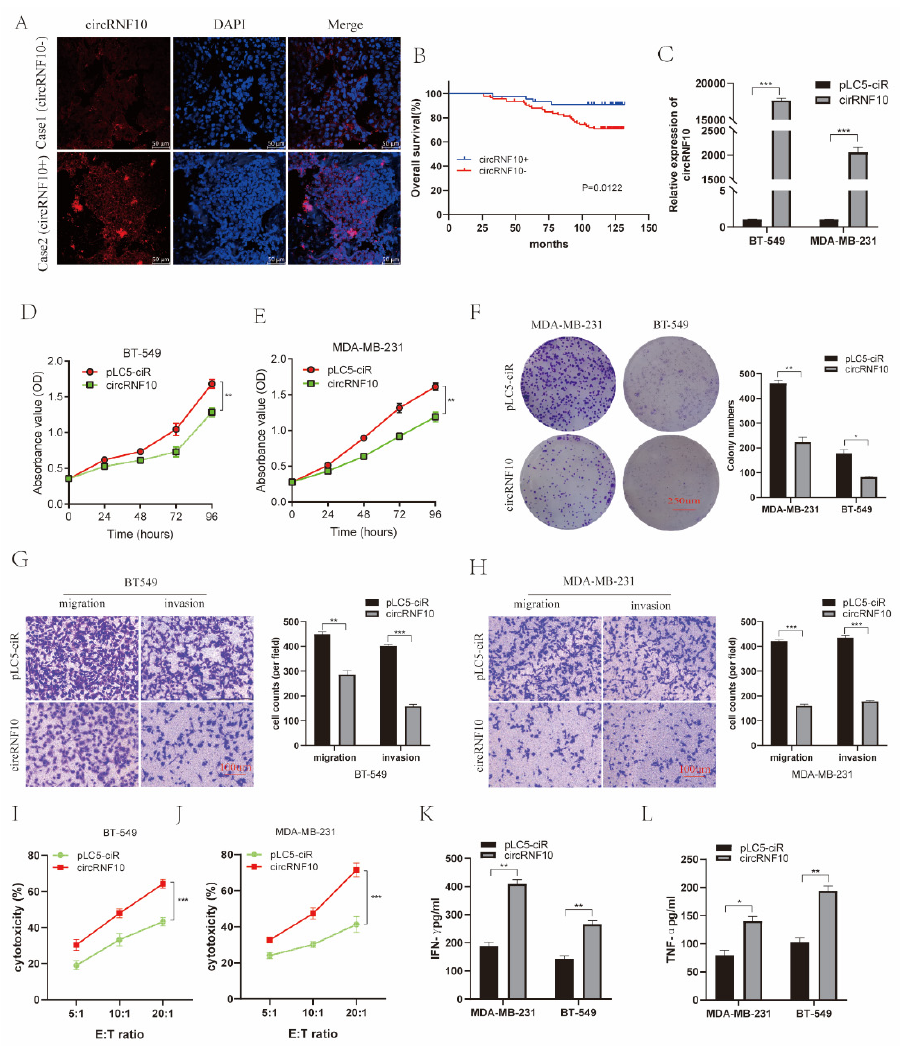
Figure 3. circRNF10 is related to BC progression, suppresses BC cell proliferation, migration, and invasion, and enhances the killing efficiency of NK-92MI cells against BC cells. ( A ) Level of circRNF10 in BC tissue specimens was observed by FISH analysis. Scale bar, 50 µ m. ( B ) Survival analysis indicated that enhanced circRNF10 expression showed a favorable prognosis for BC patients. ( C ) Level of circRNF10 in BC cells after transfection with circRNF10 was observed using qRT-PCR. *** p < 0.001. ( D , E ) CCK8 assay indicated that overexpression of circRNF10 significantly suppressed proliferation of BT-549 and MDA-MB-231 cells, respectively. ** p < 0.01. ( F ) Colony formation assay indicated that the number of cell clones was markedly decreased after upregulation of circRNF10 expression in BC cells. Scale bar, 250 µ m.* p < 0.05, ** p < 0.01. ( G , H ) Transwell assay indicated that overexpression of circRNF10 suppressed the migration and invasion abilities of BT-549 and MDA-MB-231 cells, respectively. Scale bar, 100 µ m.** p < 0.01, *** p < 0.001. ( I , J ) Cytotoxicity of NK-92MI cells was detected using the LDH assay after co-culture with overexpression of circRNF10 in BT-549 ( I ) or MDA-MB-231 (J) cells with 5:1, 10:1 and 20:1 effect-to-target ratios. *** p < 0.001. ( K , L ) Protein levels of IFN- γ and TNF- α , respectively, in supernatant of NK-92MI cells with co-cultured overexpression of circRNF10 BC cells were measured by ELISA. * p < 0.05, ** p < 0.01. All of the experiments were repeated three